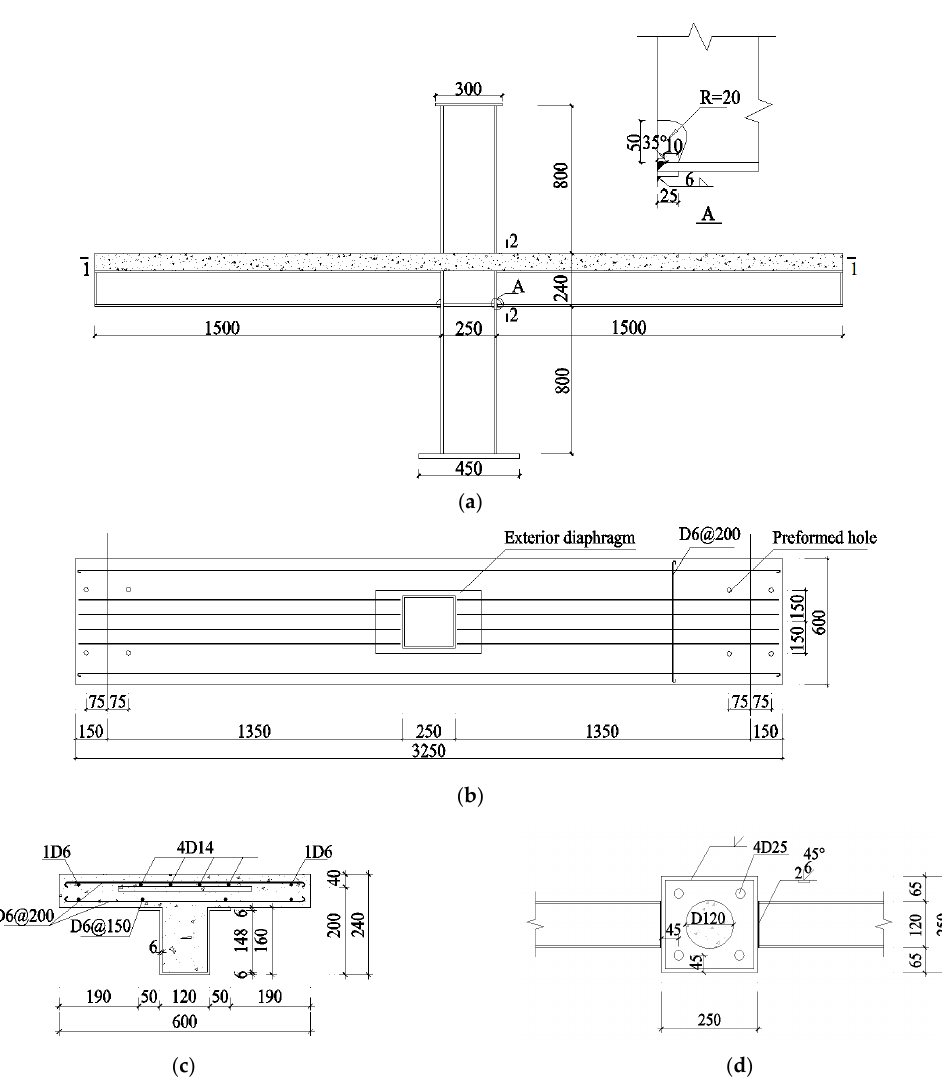
Figure 5. Details and dimensions of specimens: ( a ) the whole specimen; ( b ) section 1-1 of specimen C-1; ( c ) section 2-2 of specimen C-1; ( d ) inner diaphragm. The cold-formed square steel tube was used for the column. The U-shaped steel beam was fabricated using the cold-forming steel plate. Q235B steel with the nominal strength of 235 Mpa was used for all of the steel elements in the three specimens. Concrete with the nominal compressive cubic strength of 40 Mpa was used in the column, and concrete with the nominal compressive cubic strength of 30 Mpa (C-1, C-2) and 20 Mpa (C-3) were used in the beam and slab. Hot-rolled ribbed rebar (HRB) with a nominal yield strength of 335 Mpa was used as the longitudinal rebars in the concrete slab, and hot-rolled plain rebar (HPB) with a nominal yield strength of 235 Mpa was used as the transverse distri- bution rebar in the slab. In order to achieve full strength and stiffness of the CFUS beam, the shear studs with a diameter of 13 mm were welded onto the bottom plate and the top extending flanges of the U-shaped steel beam. A full penetration weld was used to connect the bottom plate of the U-shaped steel and the steel tube wall, where the welding pad was used during welding and removed after welding to improve the quality of welds. All of the steel members were fabricated in the steel factory, and the subsequent works were carried out at the structural laboratory of Shandong Jianzhu University, such as binding and welding the rebars, and casting and curing the concrete. Material properties of steel and concrete used for the specimens are given in Tables 2 and 3. Table 2. Material properties of steel. Type